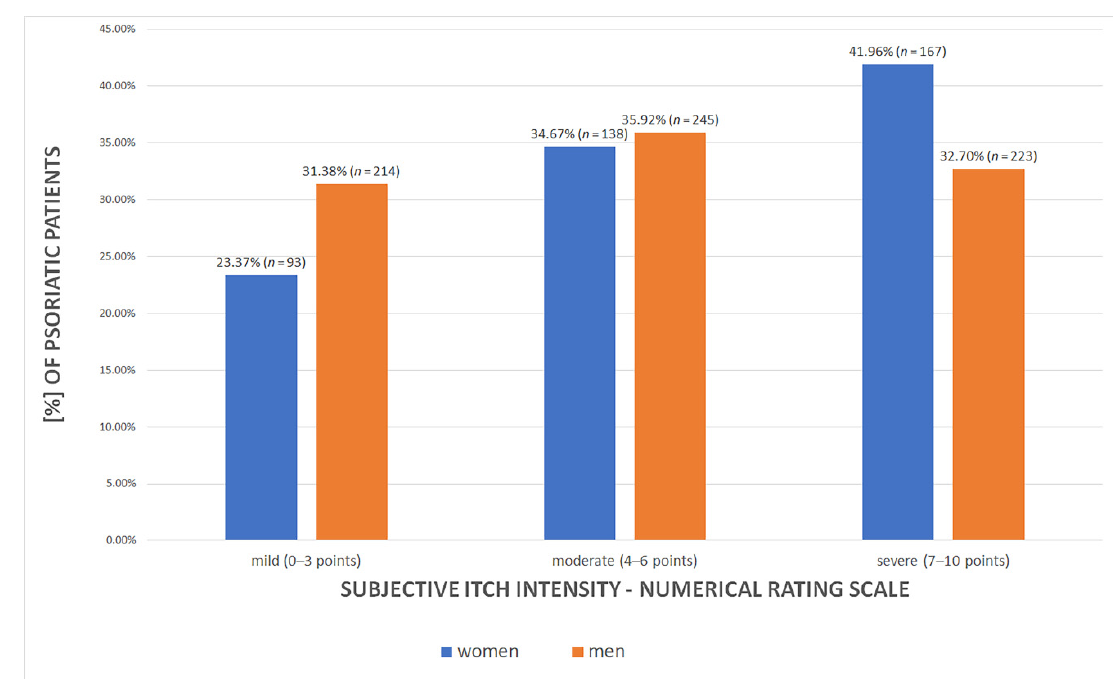
Figure 2. The intensity of itch in female and male psoriatic patients ( p = 0.003).